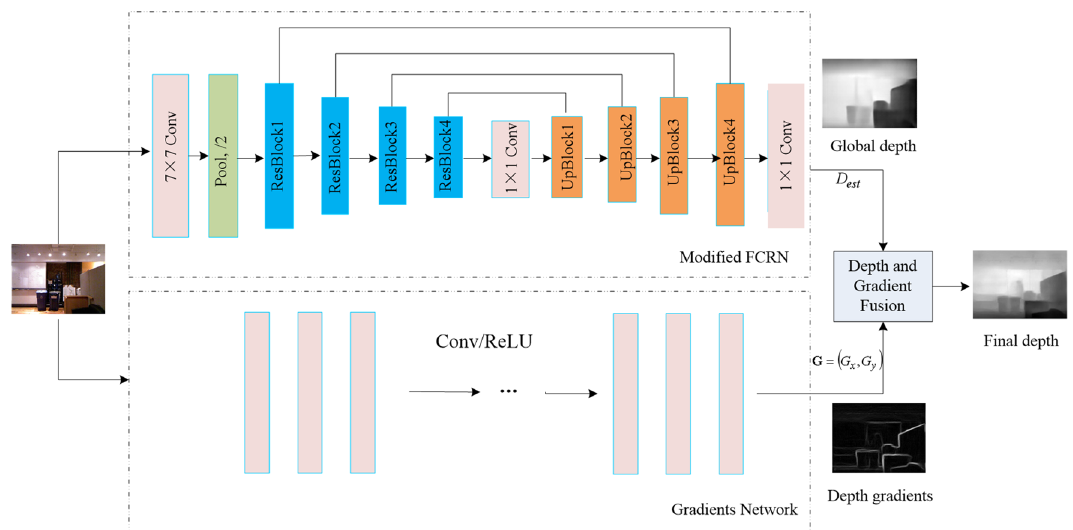
Fig. 1 Overview of our presented network